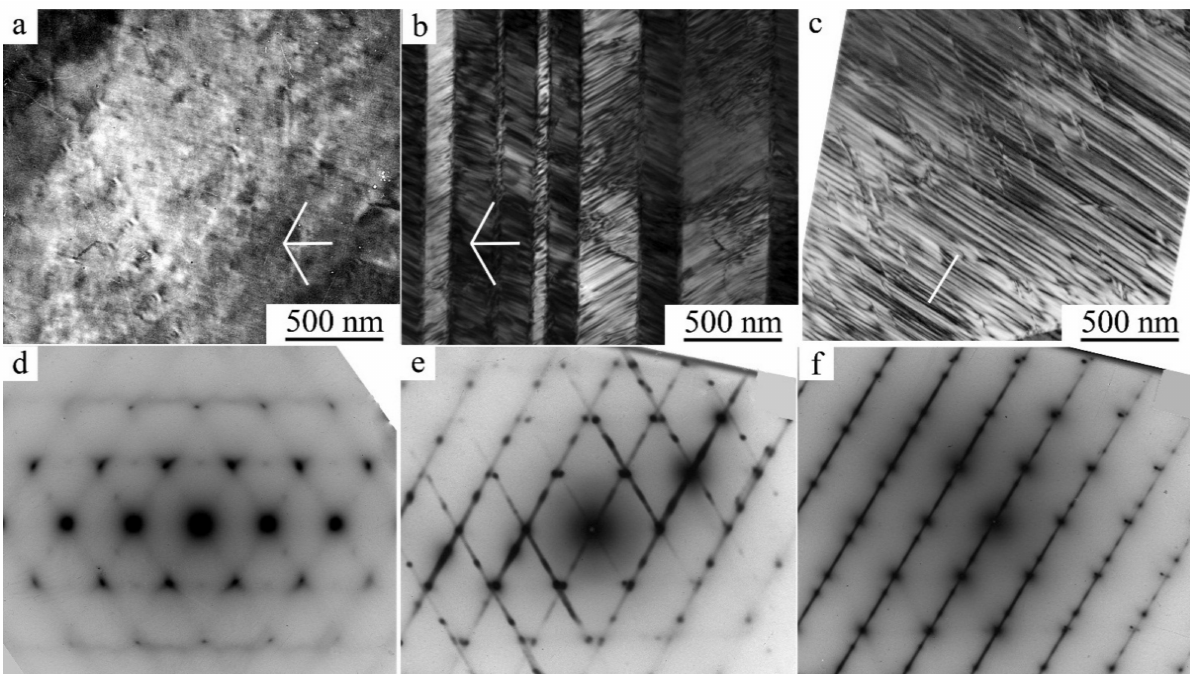
Figure 3. ( a ) Dark-field and ( b , c ) bright-field TEM images ( a ) of the tweed contrast in the β 1 -austenite, ( b ) twinned γ 1 (cid:48) martensite, and ( c ) β 1 (cid:48) martensite of the quenched alloy Cu–13.5Al–3.5Ni, and ( d – f ) their corresponding SAED patterns, with zone axis close to [111]; D0 3 . Observations ( a , d ) at 450 K, and ( b , c , e , f )–at RT. In addition, white lines ( a , b , c ) denote the directions of the normals to (i) the planes of {111} type, (ii) the traces of stacking faults, and (iii) the micro twins of the martensitic crystals with the same habit, which is close to {111} D0 3